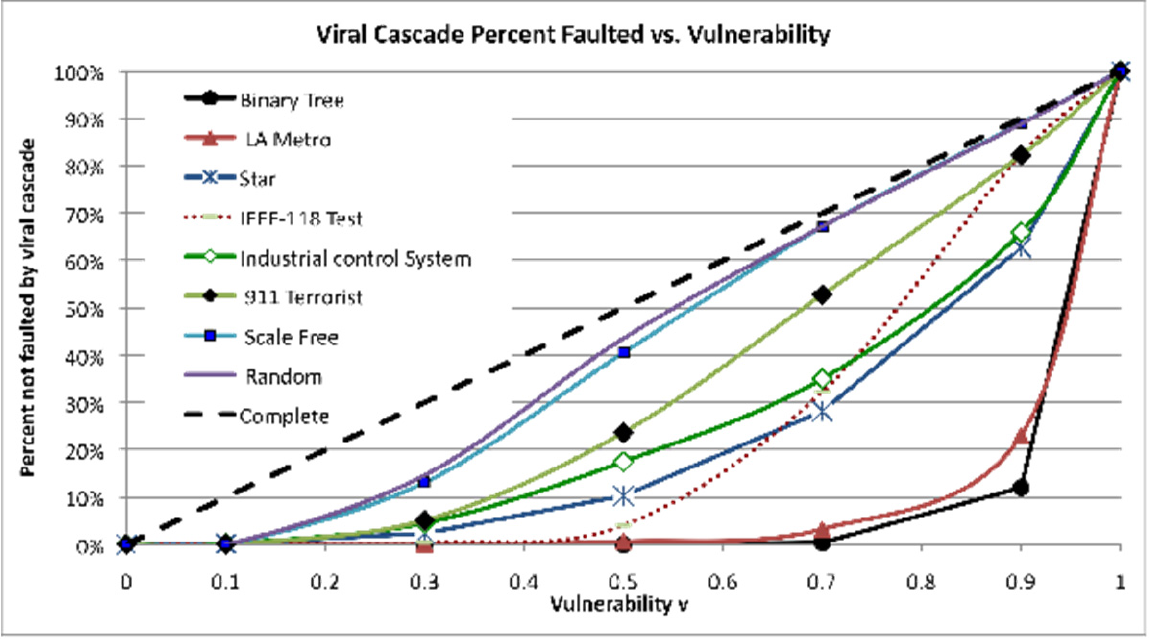
Figure 9. Percentage of nodes faulted versus vulnerability V. Correlation = 0.86 on average. Branchy networks (Binary tree, LA Metro, IEEE-118 Test) tend to spread faults less than bushy networks, hence they are more resilient.